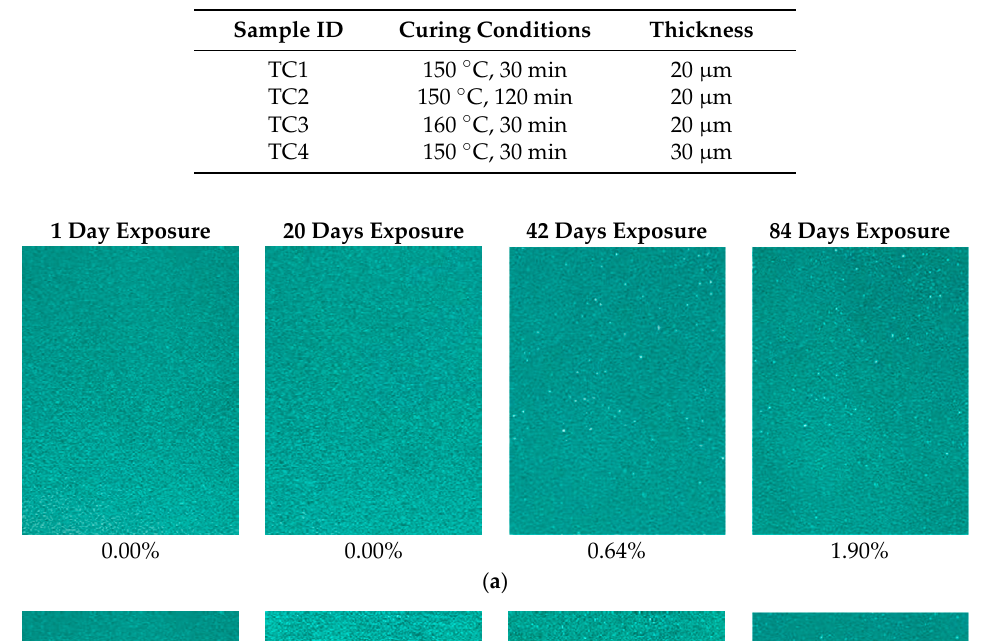
Table 2. Curing temperature and duration of sol-gel topcoat with their respective thickness values.